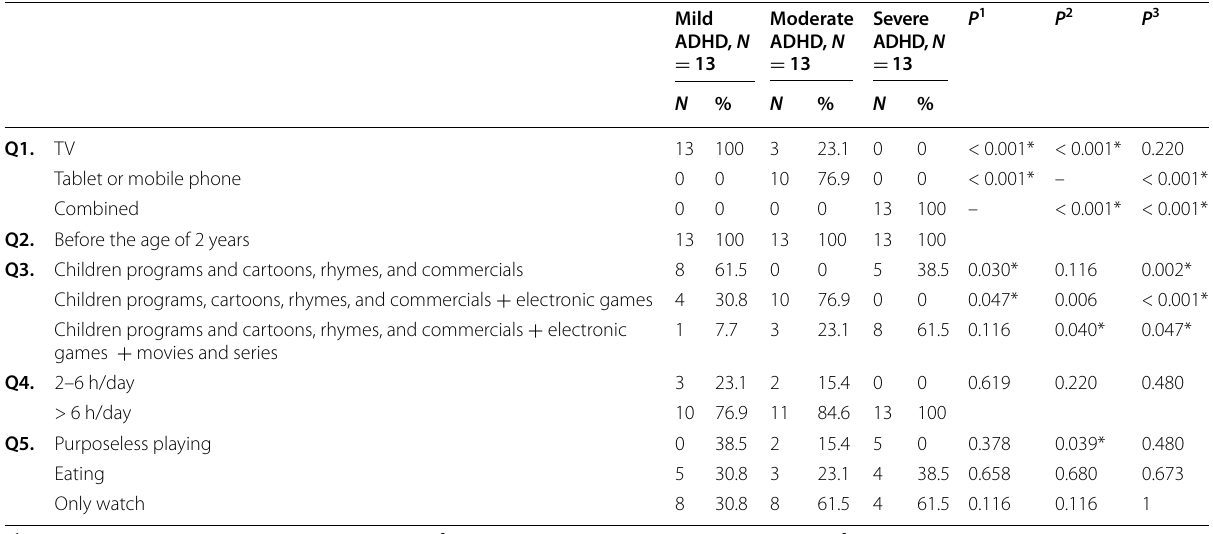
P 1 , comparison between mild ADHD and moderate ADHD; P 2 , comparison between mild ADHD and severe ADHD; P 3 , comparison between moderate ADHD and severe ADHD. Categorical data are expressed as numbers and percentages, compared by the chi-square or Fisher exact tests